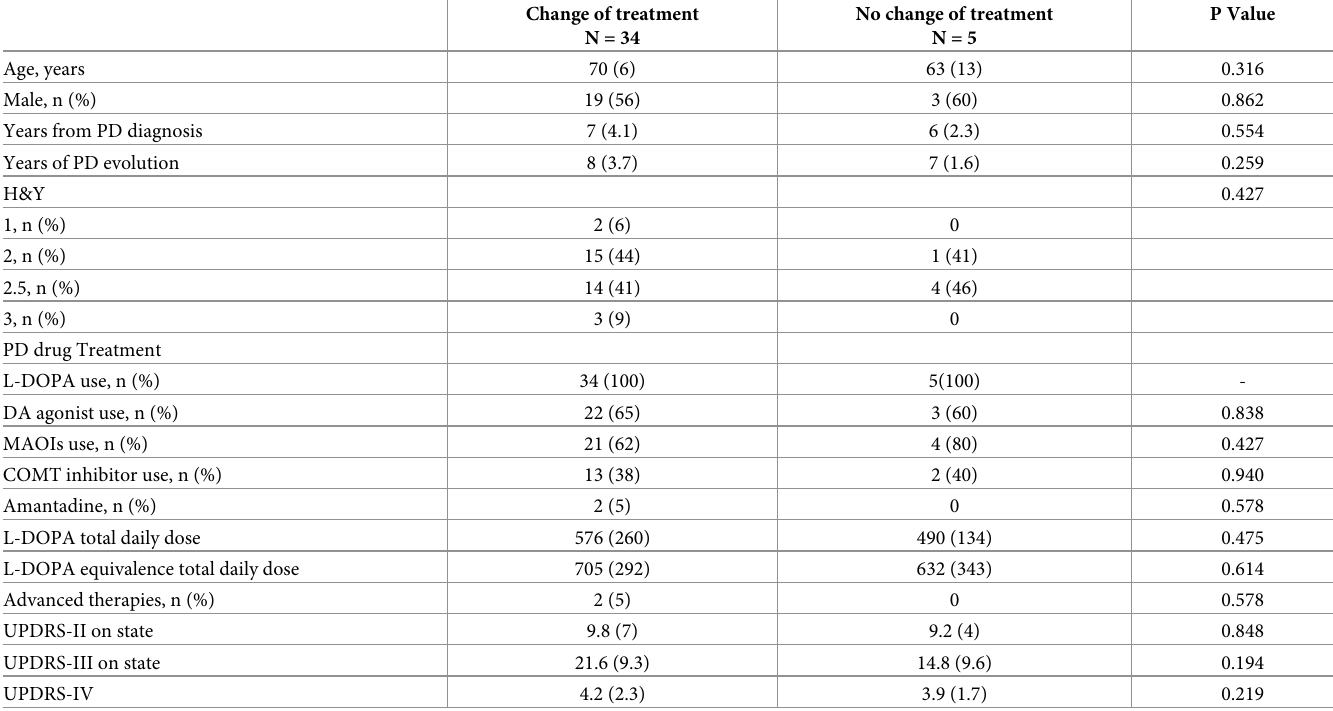
Table 1. Characteristics of the study sample.